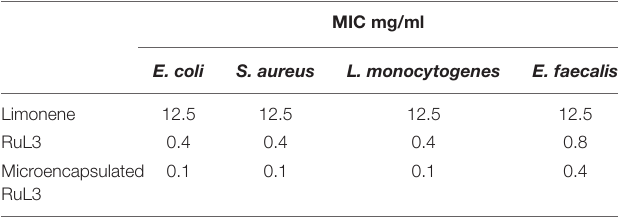
TABLE 1 | Minimum inhibitory concentration values (mg/ml) of limonene, RuL3, and microencapsulated RuL3 against Escherichia coli , Staphylococcus aureus , Listeria monocytogenes , and Enterococcus faecalis .